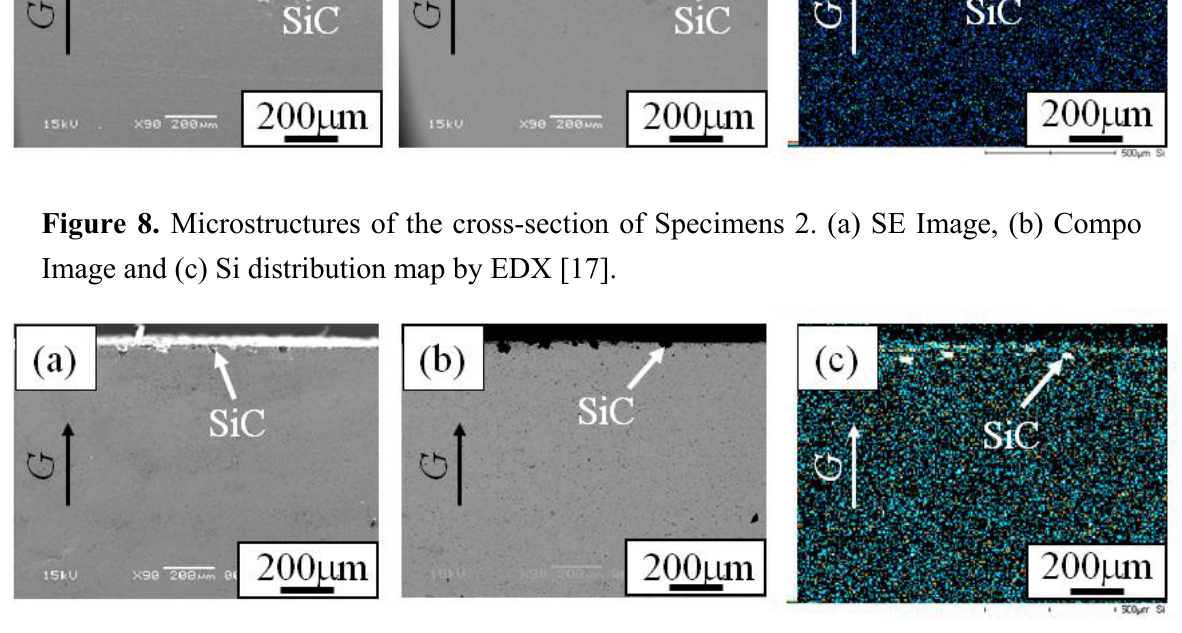
Figure 9. Microstructures of the cross-section of Specimens 3. (a) SE Image, (b) Compo Image and (c) Si distribution map by EDX